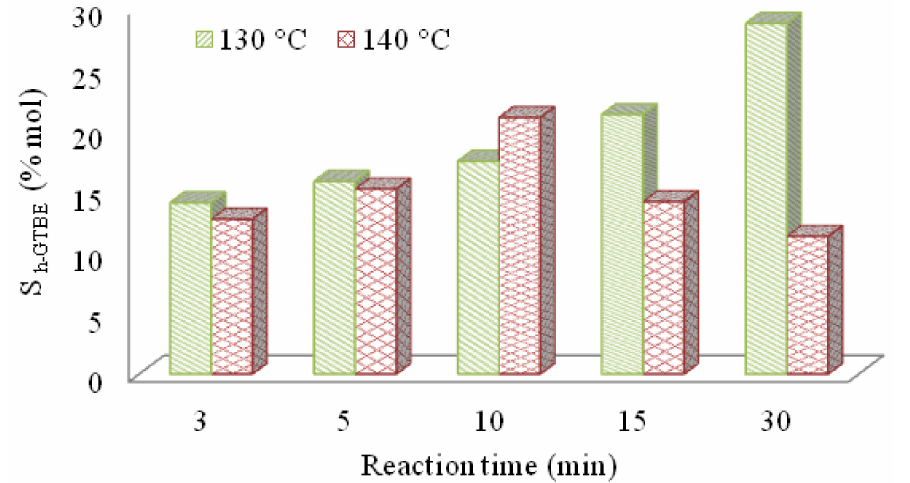
Figure 7. Selectivity to h-GTBE vs time profile at 130 ◦ C (green lines) and 140 ◦ C (red squares) over catalyst 1 . Reaction conditions: TBA / G molar ratio = 4; catalyst amount 5 wt.%.